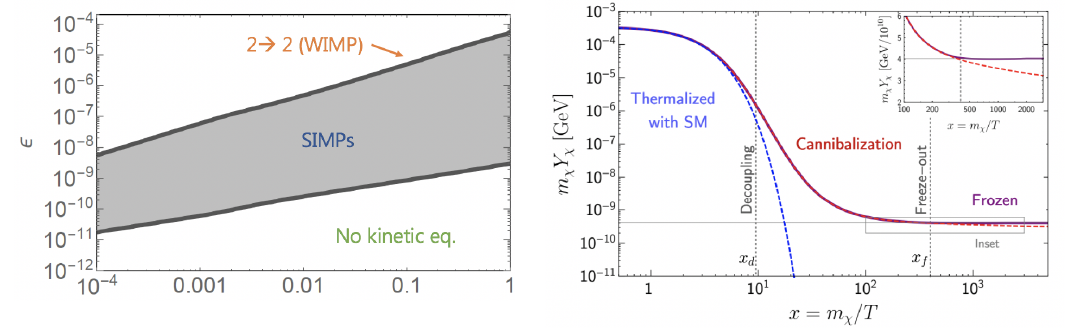
Figure 3: Left: Range of couplings between the DM and the SM where SIMP DM emerges. Right: Reproduced from [ 7 ] , the DM yield as a function of SM temperature for ELDER DM, for DM mass 10 MeV, ε ∼ 10 − 9 and strong α